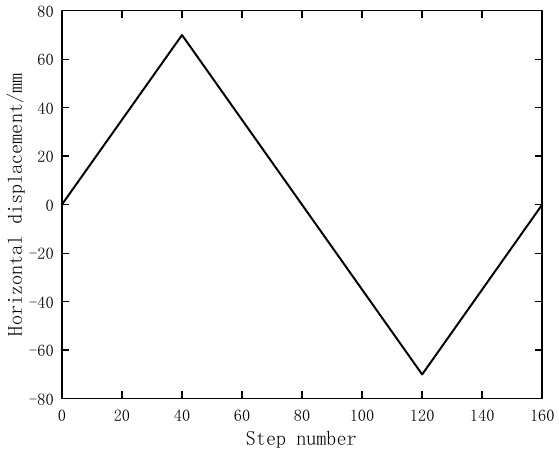
Figure 10. Loading curve.